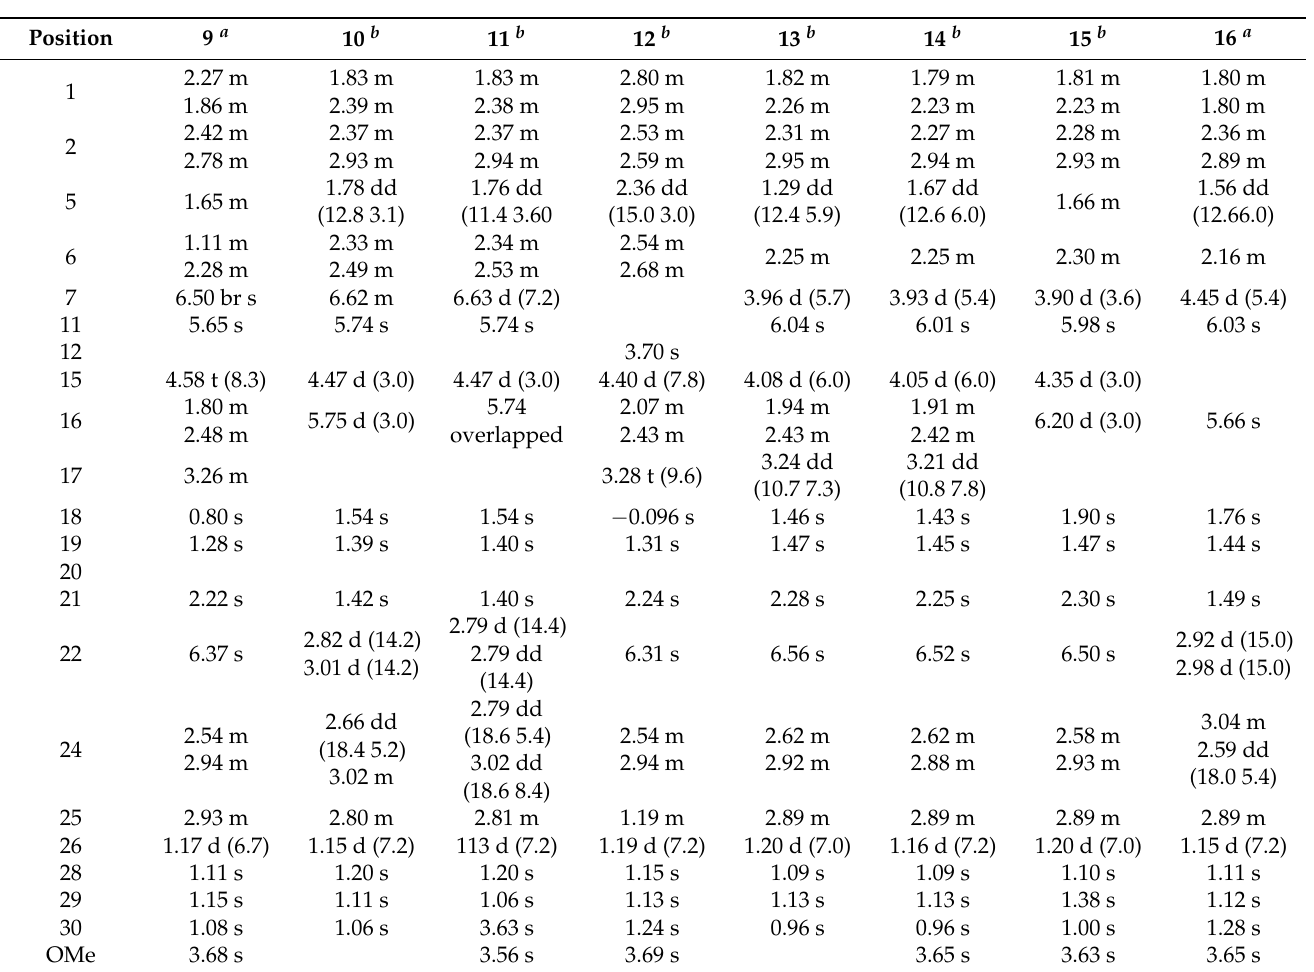
Table 3. 1 H NMR spectra of compounds 9 – 16 (600 MHz, J in Hz, δ in ppm